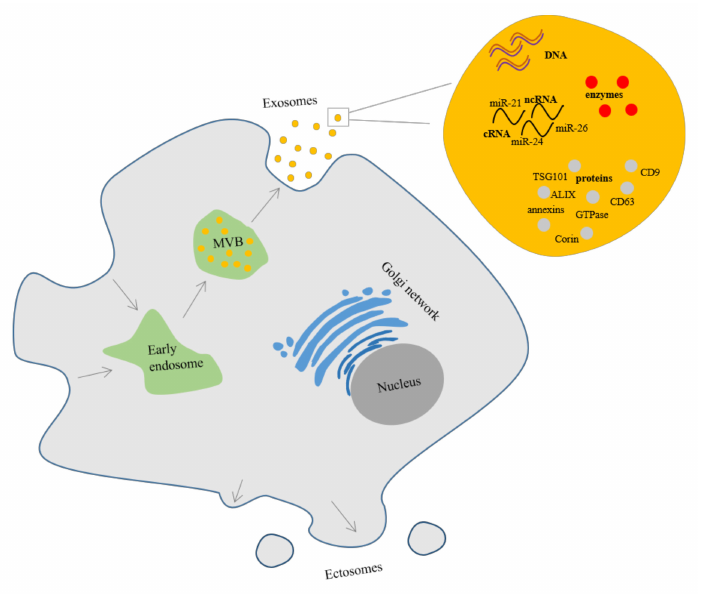
Figure 2. Exosomes and ectosomes secretion in adipose-derived stem